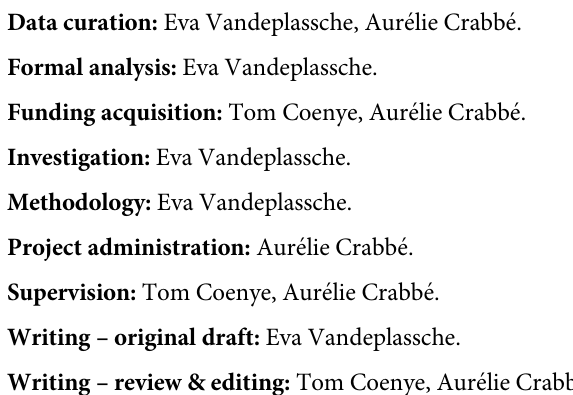
S3 Fig. Validation of the novel selective media. Planktonic mono-species cultures and a mixed culture were plated on the newly developed selective media and showed equal recovery. Graphs show mean recovery and standard deviations. (TIF) S4 Fig. Proof of concept: Quantification of multispecies biofilms. A multispecies biofilm of the six bacterial species was grown for 48 hours and subsequently incubated with fresh medium as an untreated control or treated with 100 μg/mL tobramycin in medium for an additional 24 hours in microaerophilic conditions. Graphs show mean recovery and standard deviations. The detection limit of 10 2 CFU/mL is represented by a dashed line. (cid:3) p < 0.05, n (cid:21) 3.